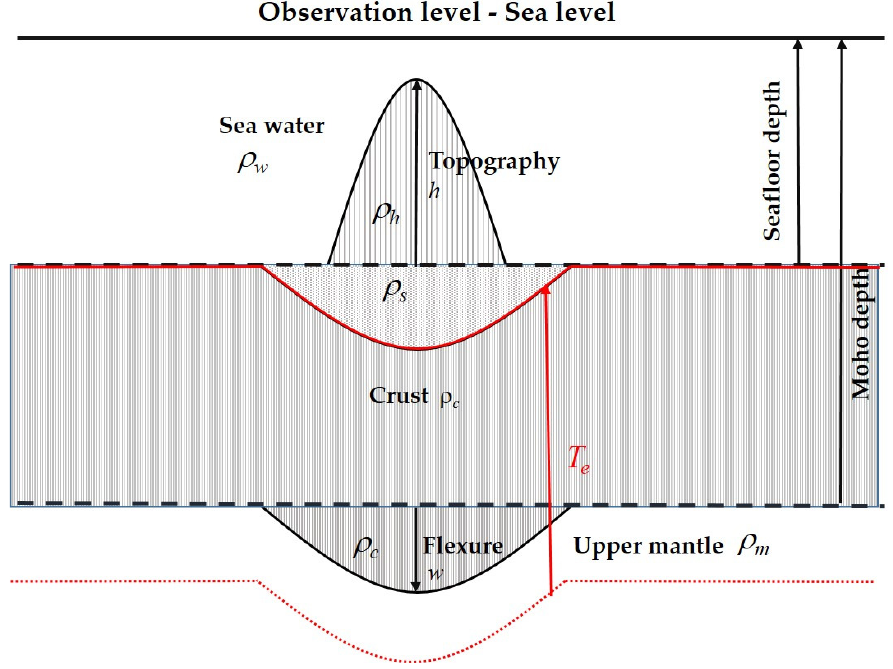
Figure 1. Four layers lithospheric sea-crust-mantle model composed of the sea floor topography h and the lithospheric deflection w . Inspired by [37].